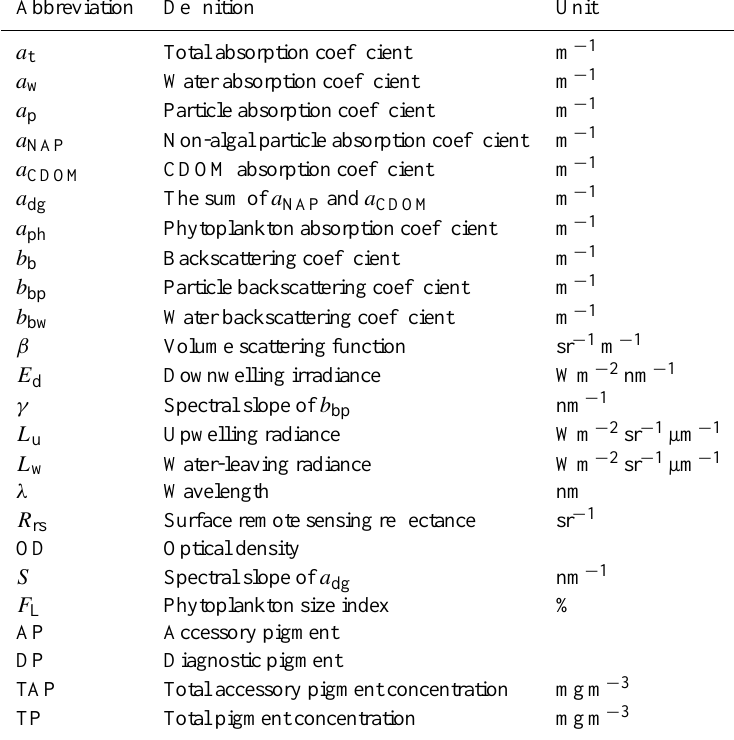
Table 1. List of symbols and